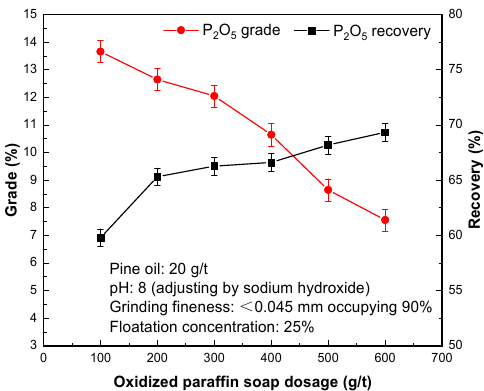
Figure 3. E ff ect of oxidized para ffi n soap dosage on extracting phosphorous. Figure 3. Effect of oxidized paraffin soap dosage on extracting phosphorous.